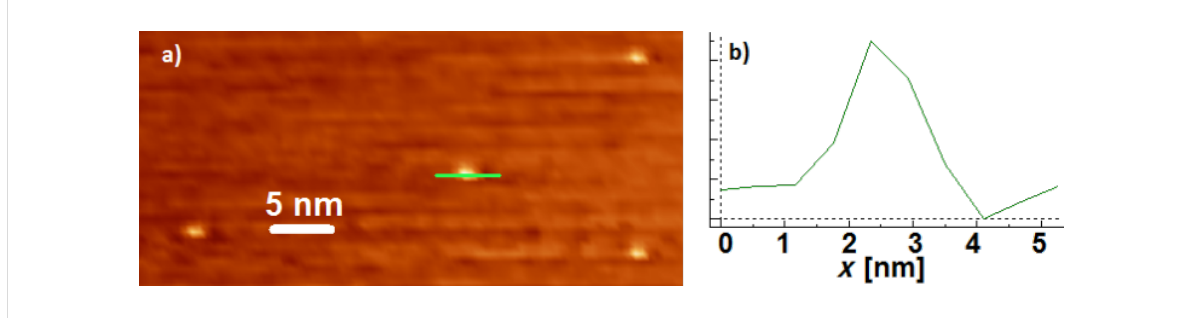
Figure 3: a) STM morphology measurements of AgNP-3MPS (synthesis b) and b) the height profile of one nanoparticle.